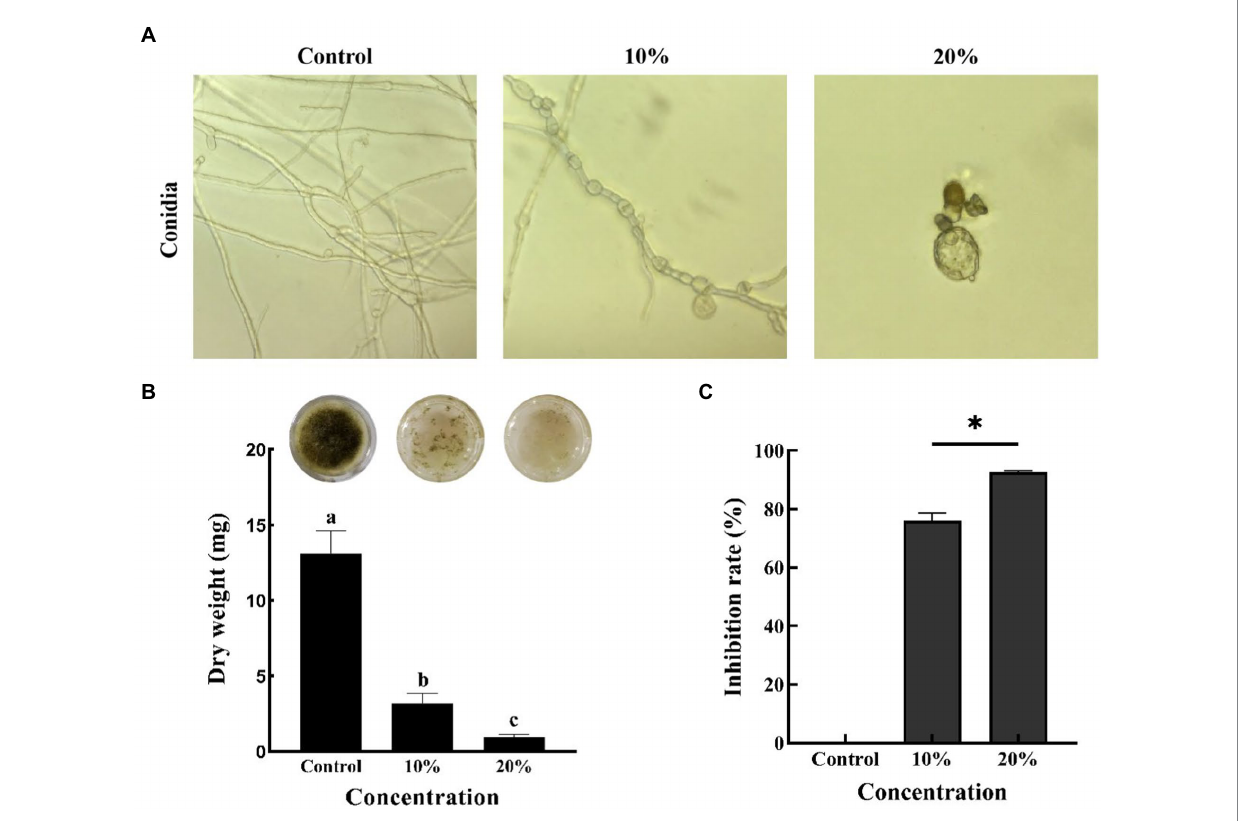
FIGURE 2 Inhibition of cell-free culture filtrate with different concentrations on Bipolaris sorokiniana . (A) Effect of cell-free culture filtrate on conidial germination of Bipolaris sorokiniana . (B) Effect of cell-free culture filtrate on dry weight of mycelium. (C) Inhibition rate of cell-free culture filtrate against Bipolaris sorokiniana . Error bars represent the standard deviation ( n = 3). Different letters and * indicated a significant difference at the level of p < 0.05.